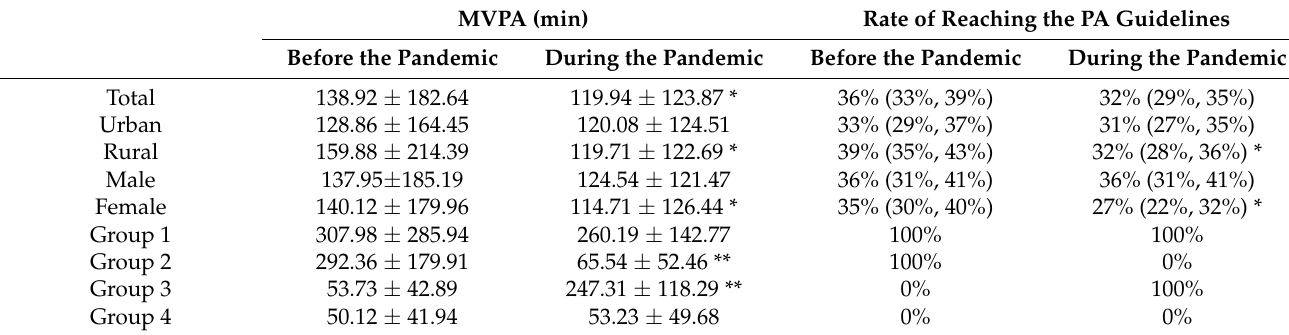
Table 3. Changes in physical activity among different groups before and during the pandemic.